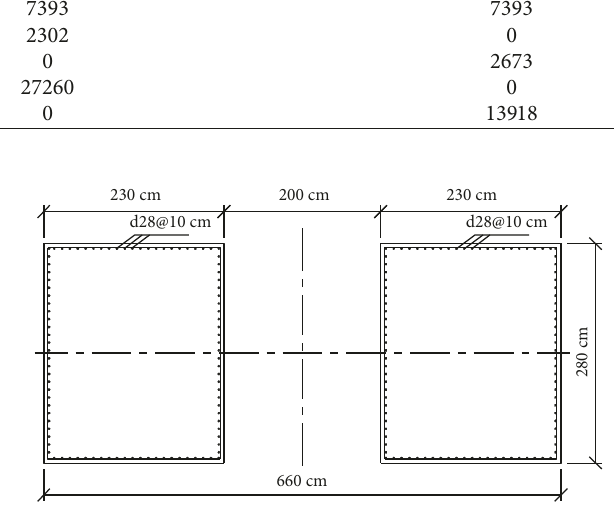
Figure 13: Pier reinforcement detail (cross